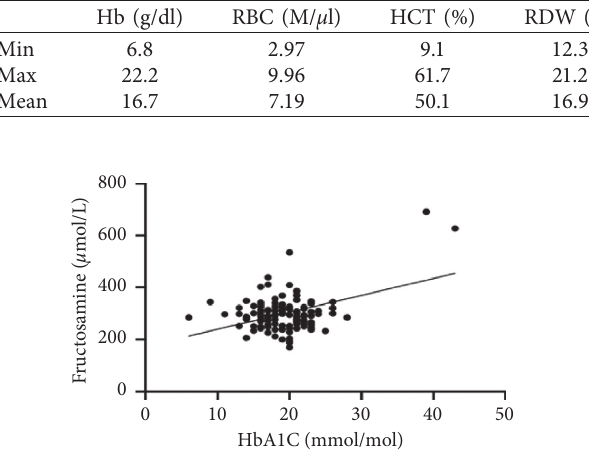
Figure 4: Relation between red blood cells and HbA1c ( r � 0.104; p < 0 . 0004).